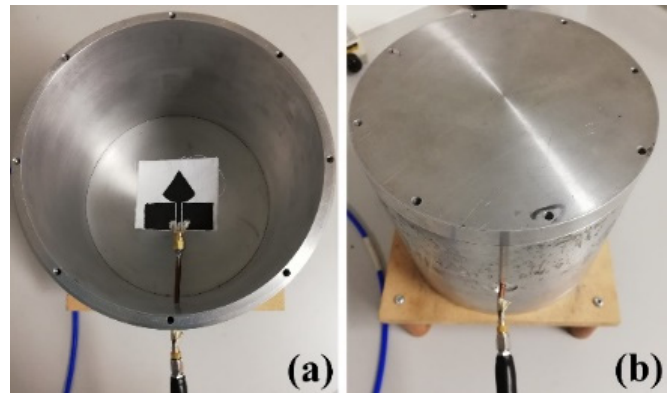
Figure 5. Laboratory model of a cylindrical wheeler cap: ( a ) Cap-off; ( b ) Cap-on.